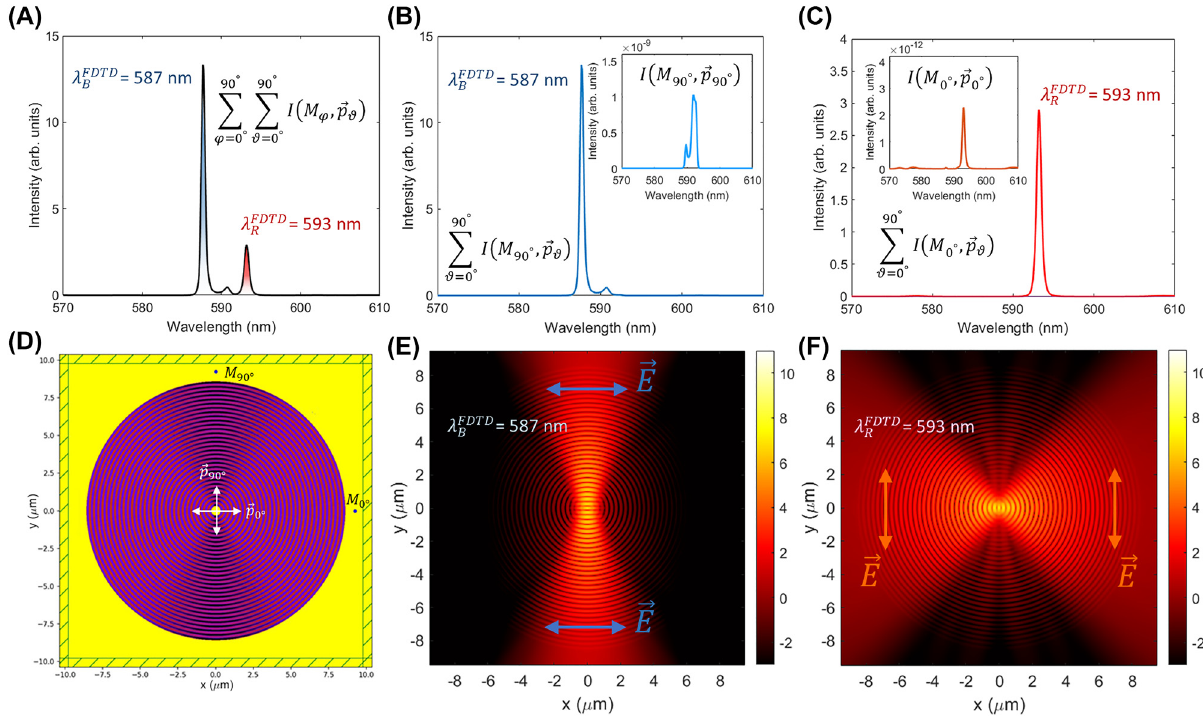
Figure 6: 2D FDTD model of the BSW cavity. (A) Sum of intensity spectra collected by M and M , produced by an incoherent superposition of 0 ◦ 90 ◦ and ⃗ p ; (B) intensity spectrum collected by M , produced by ⃗ p and ⃗ p incoherently superposed. Inset: spectrum at M , produced sources ⃗ p 0 ◦ 90 ◦ 90 ◦ 0 ◦ 90 ◦ 90 ◦ showing a negligible contribution to the mode coupling at 𝜆 FDTD ; (C) intensity spectrum collected by M , produced by ⃗ p and ⃗ p incoherently by ⃗ p 90 ◦ 0 ◦ 0 ◦ 90 ◦ R , produced by ⃗ p showing a negligible contribution to the mode coupling at 𝜆 FDTD ; (D) geometry of the FDTD model superposed. Inset: spectrum at M 0 ◦ 0 ◦ R with monitors M and M on the x -axis and y -axis, respectively. The two orthogonal sources are in the cavity centre as shown by white arrows; 0 ◦ 90 ◦ = 587 nm (E) and 𝜆 FDTD = 593 nm (F). Both intensity distributions are calculated by the incoherent sum of the intensity intensity distribution at 𝜆 FDTD B R and ⃗ p . Colour scale is logarithmic. Arrows indicate the orientation of the electric field on the reference distributions from the two source ⃗ p 0 ◦ 90 ◦